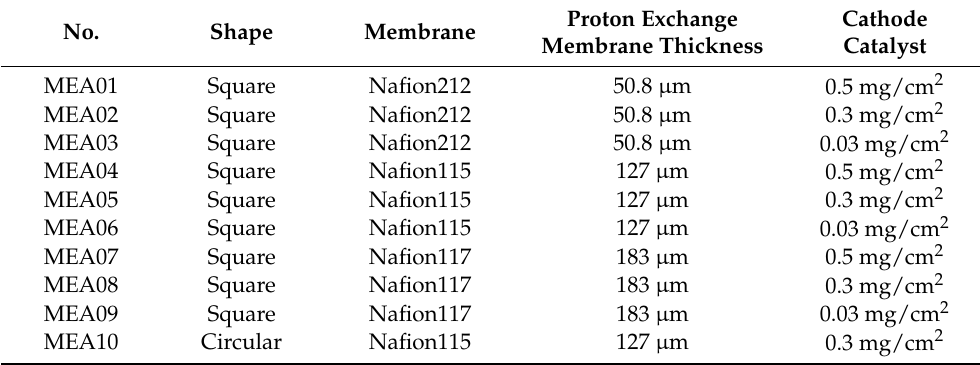
Table 3. Physical parameters of